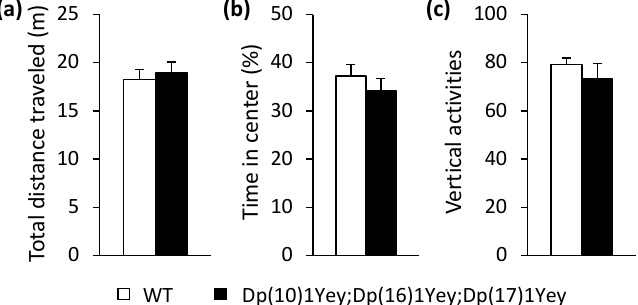
Figure 4. Open field test: Dp(10)1Yey;Dp(16)1Yey;Dp(17)1Yey and the wild-type control mice were placed in the open field arena for 10 min and their activities were recorded. There were no significant differences between these two groups of mice in terms of the total path traveled ( a ) ( p = 0.67), time spent in the center arena ( b ) ( p = 0.39), or total times of rearing ( c ) ( p = 0.38).